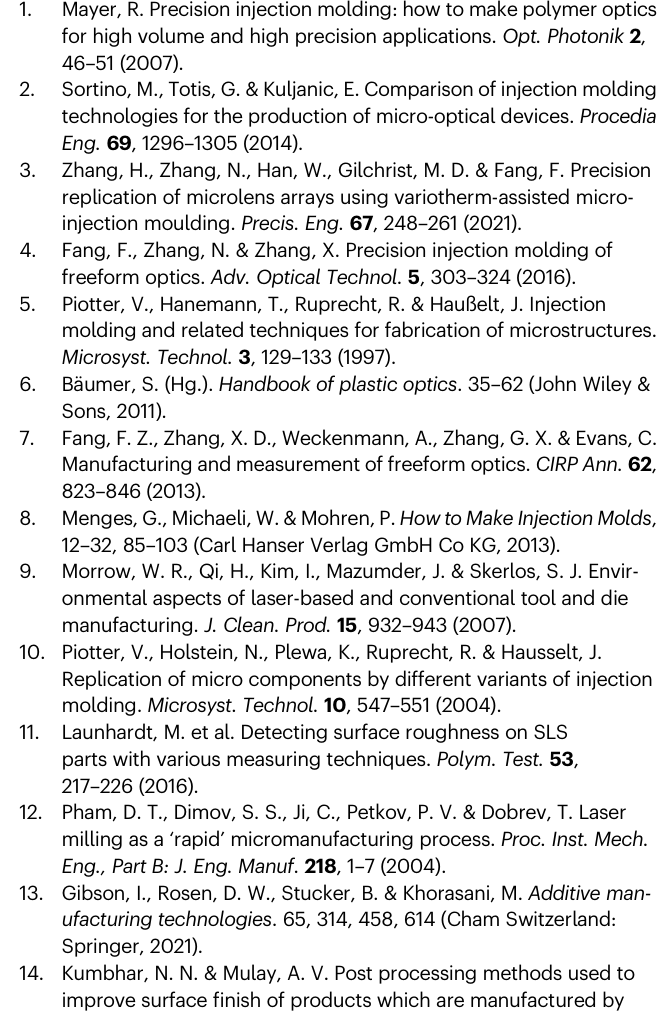
Replication of the master structures